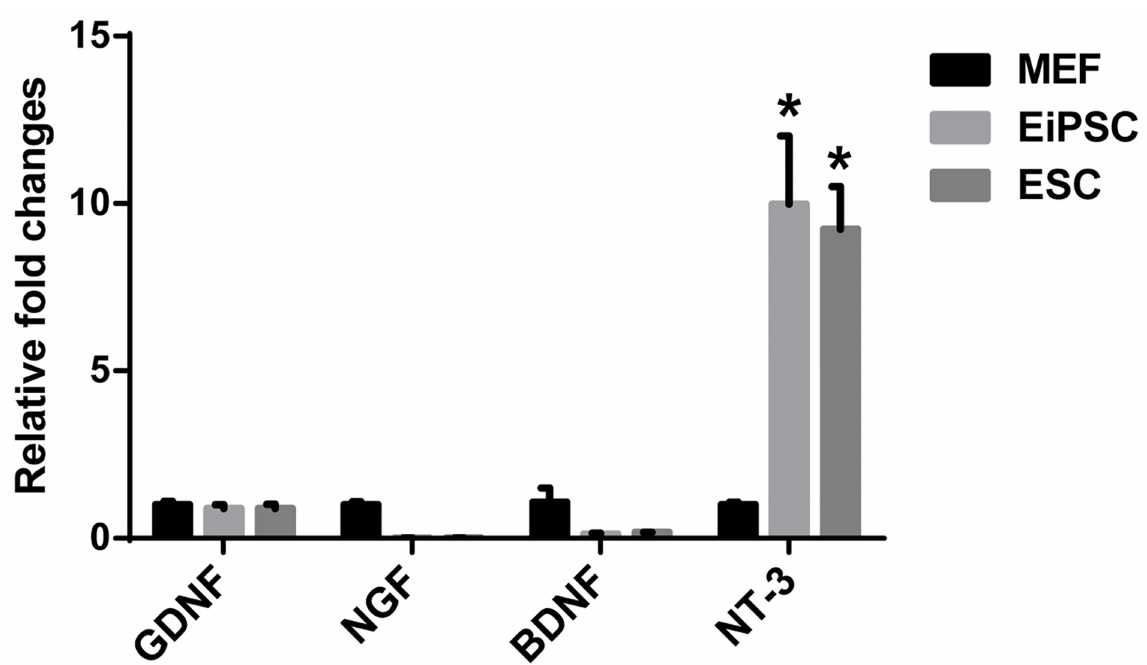
Fig 6. Quantification of stem cell derived neurotrophic factors. Chart comparing mRNA levels of glial-derivedneurotrophic factor (GDNF), neurotrophic growth factor (NGF), brain-derived neurotrophic factor (BDNF) and neurotrophic factor 3 (NT-3) produced by MEF, EiPSCs and ESCs quantifiedusing